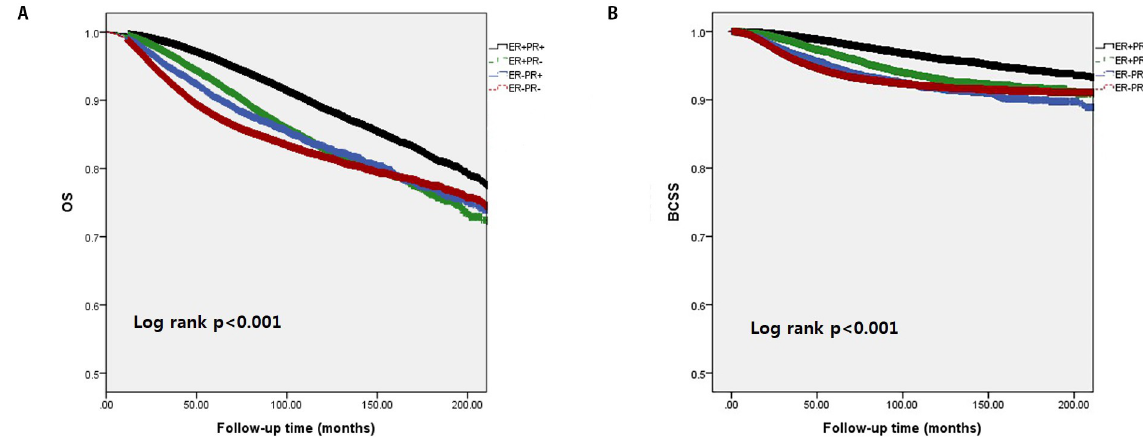
Fig 2. Kaplan–Meier survival analysis of overall survival (OS) (A) and breast cancer-specific survival (BCSS) (B) according to estrogen receptor and progesterone receptor status.